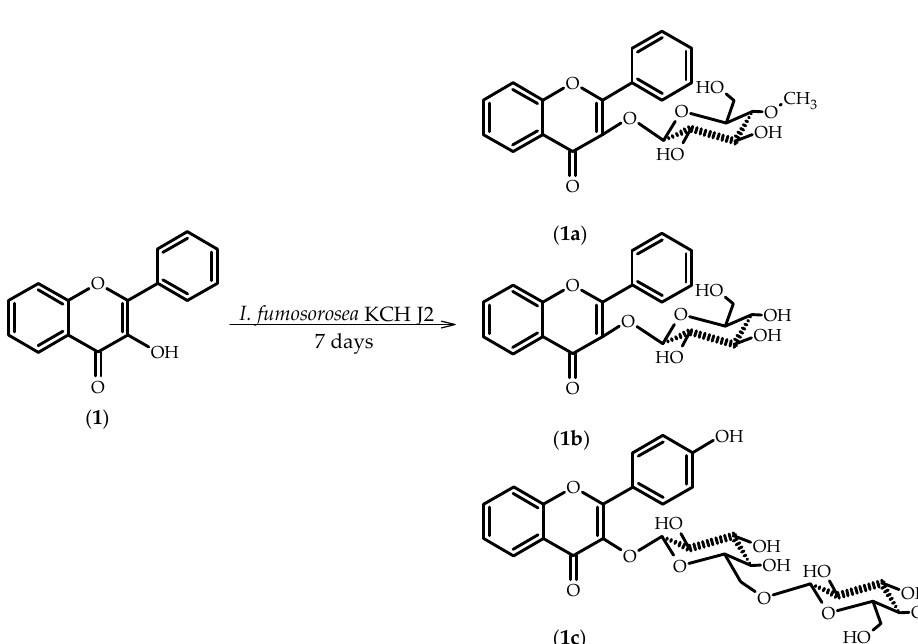
Scheme 1. Microbial transformation of 3-hydroxyflavone (1) in I. fumosorosea KCH J2 culture.